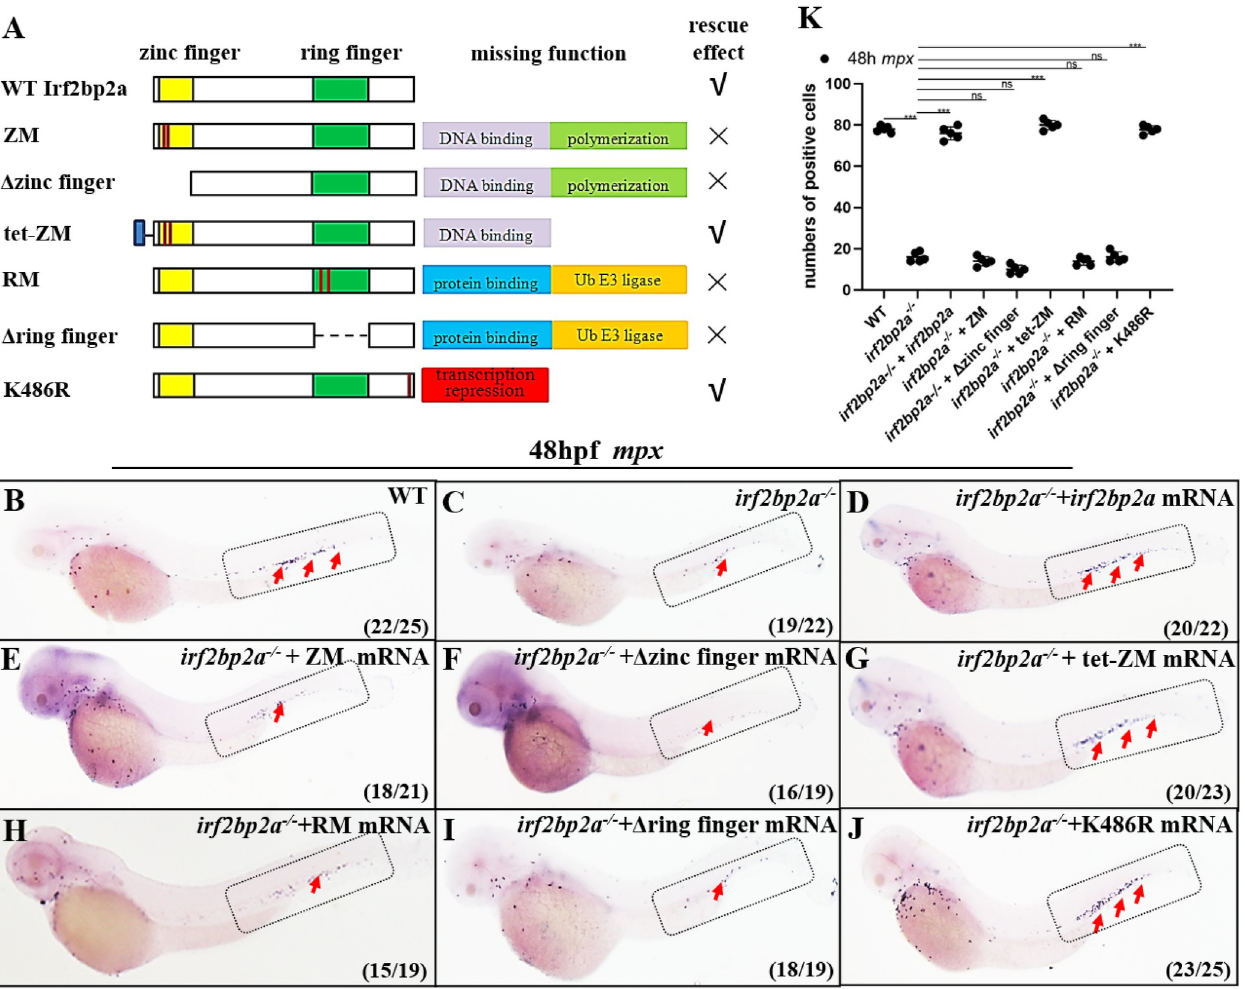
Fig 3. Polymerization and potential ubiquitin E3 ligase function are indispensable for Irf2bp2a in regulating the differentiation of neutrophilss. (A) Structure, missing function and rescue effect of wild type and variant forms of Irf2bp2a. (B-J) Irf2bp2a mRNA rescue assays in irf2bp2a -/- embryos. Mpx probe was used in WISH to examine rescue effect with wild irf2bp2a (D), ZM (E), Δ zinc finger (F), tet-ZM (G), RM (H), Δ ring finger (I) and K486R mutant (J) mRNA injections. (K) The statistical significance was calculated by using one-way ANOVA. The statistical significance was calculated using 1-way ANOVA followed by Dunnett T3 correction. The asterisk indicates a statistical difference (N = 5, 15–25 embryos were used for each experiment. Each dot represents the mean value of one experiment. Error bars represent mean ± SEM. ns: no statistical significance; ��� P <